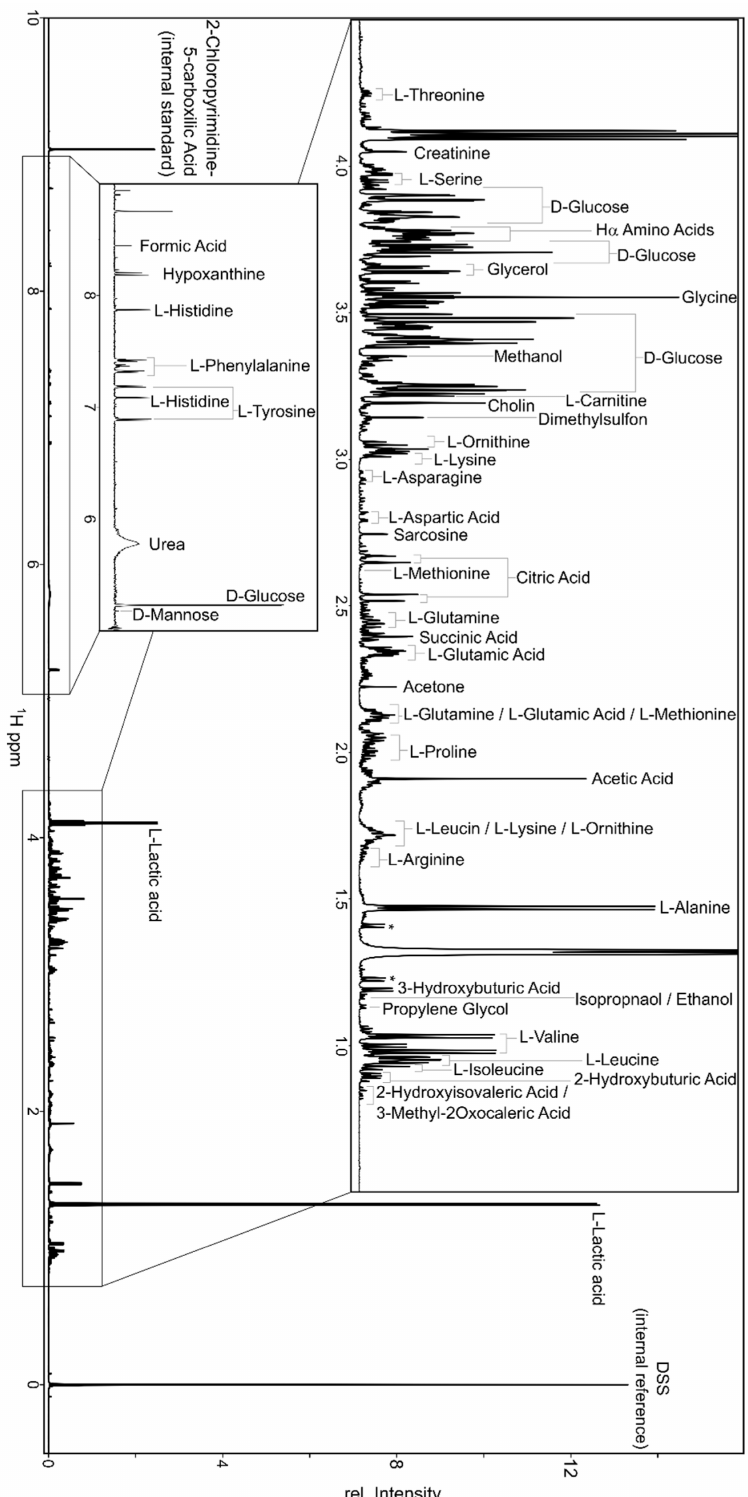
Figure A2. 1 H NMR spectrum of ultrafiltered human serum at 700 MHz with the identified com- pounds labeled above each of the corresponding peaks. Figure reprinted from Ref. [3] under the terms of the Creative Common CC-BY